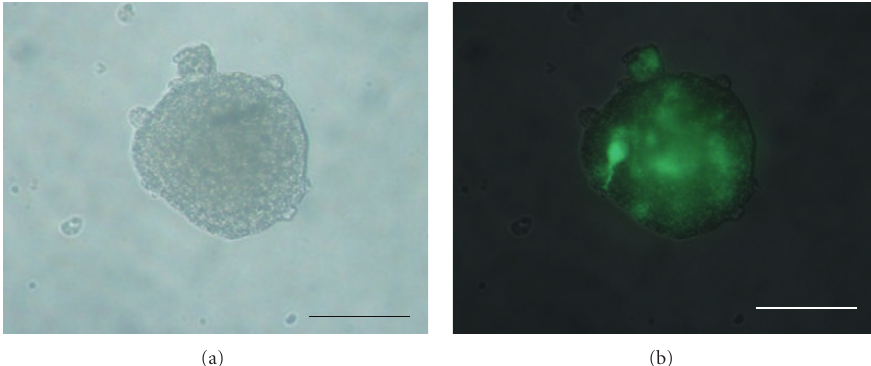
Figure 1: LV-GFP-labeled secondary neurosphere from adult pig SVZ, just before transplantation and 3 days after in vitro infection with the lentiviral vector of GFP, as observed under a photonic microscope with natural light (a) or GFP fluorescence (b). Scale bars: 50 μ